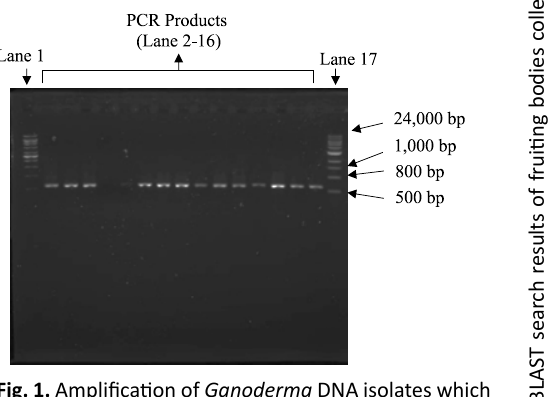
Fig. 1. Amplification of Ganoderma DNA isolates which produced approximately 650 bp size of PCR product using primers ITS1 and ITS4. Lane 1 and 17: 1kb DNA ladder, lane 2-16: PCR